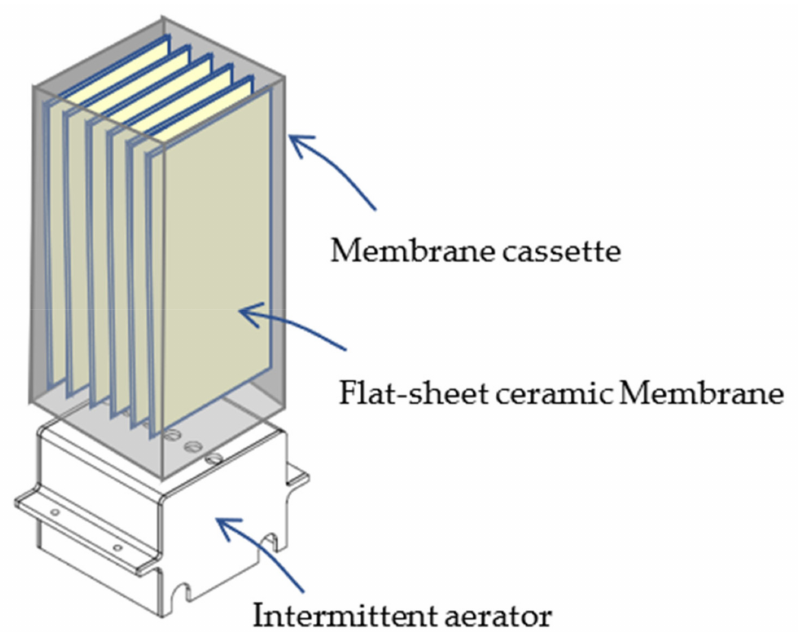
Figure 1. Membrane cassette with the intermittent